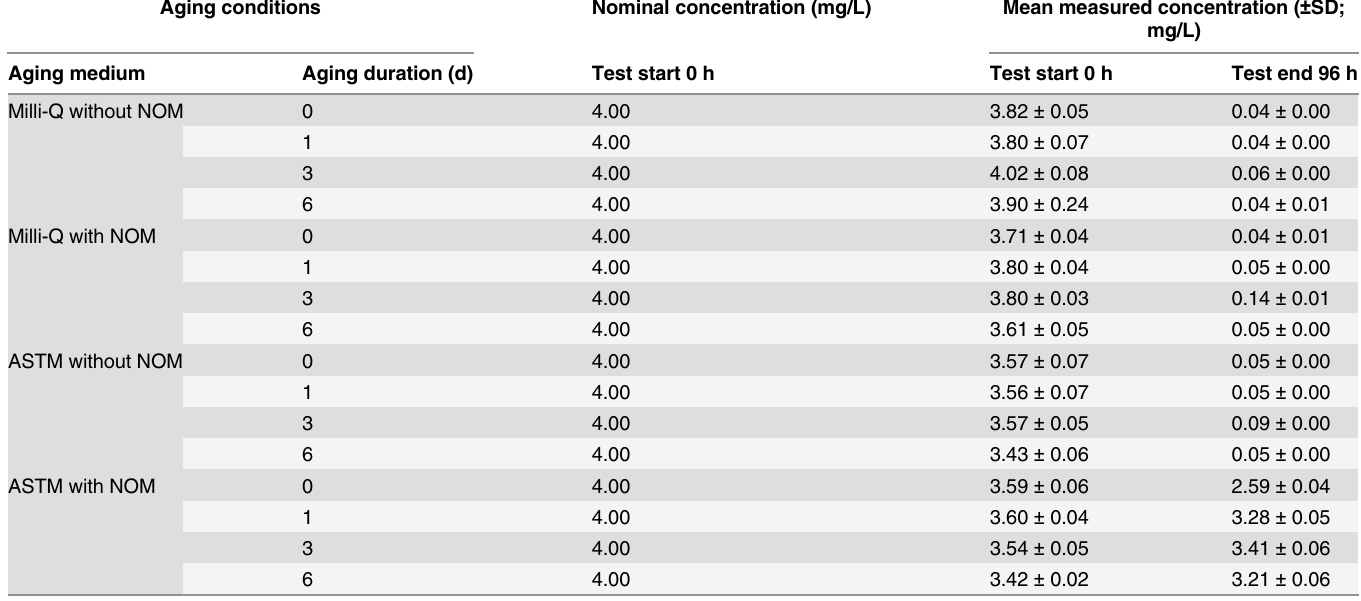
Nominal and mean measured ( ± SD; n = 3) nTiO 2 concentrations after 0, 1, 3 and 6 d aging in the respective aging medium, namely ASTM with and without NOM (8 mg